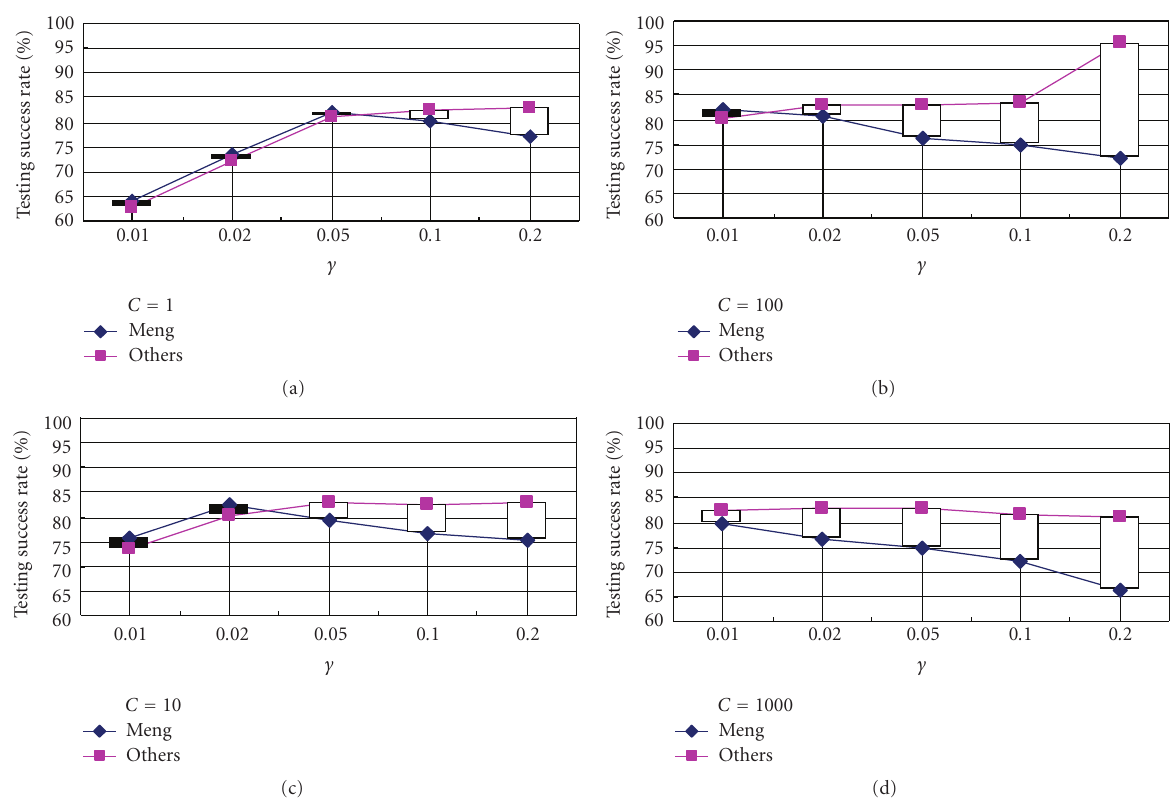
Figure 9: Success rate of model Meng versus Others parameterized with γ .